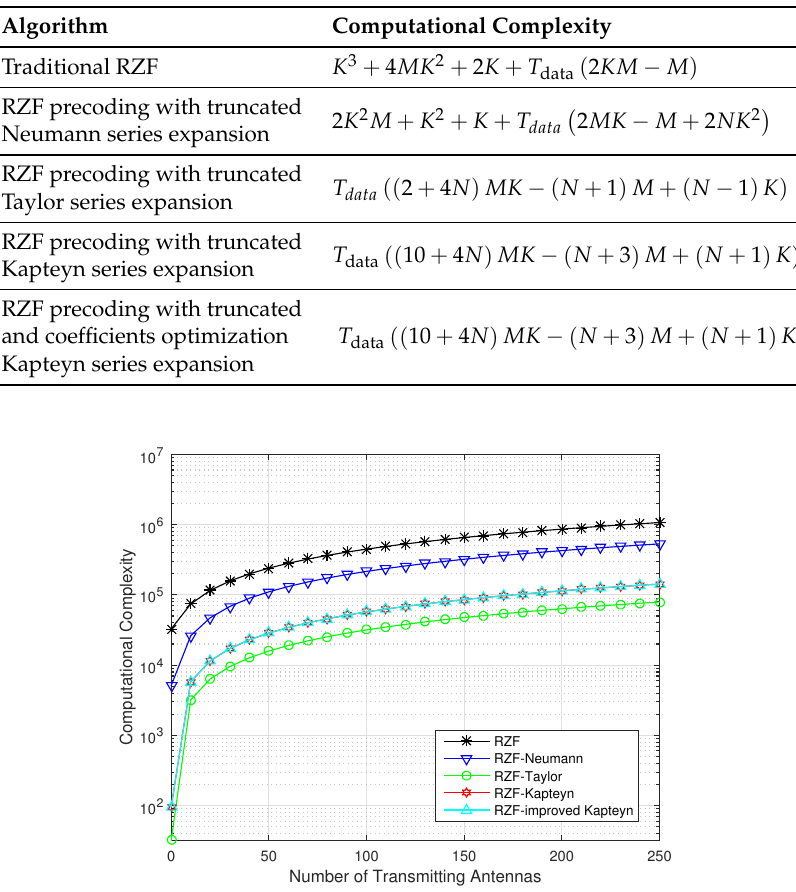
Table 1. Computational complexity comparison of five algorithms.